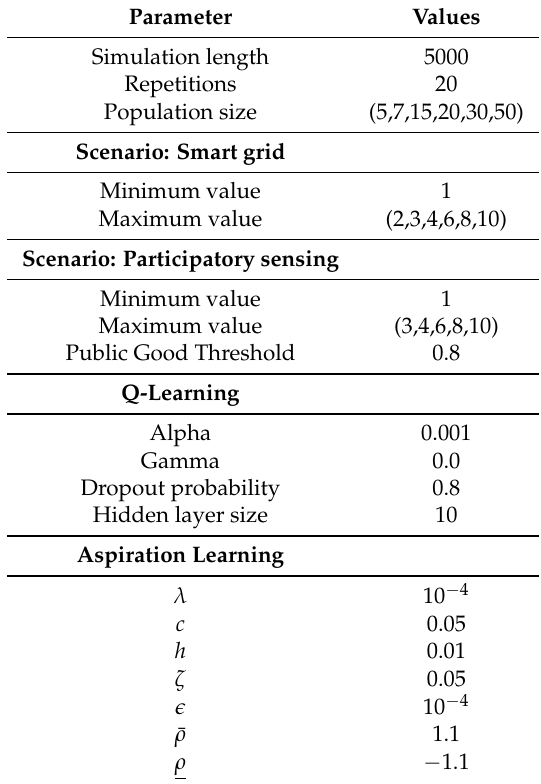
Table 4. List of parameters in the simulation environment. Tuples represent the values of parameters that have been tested during the parameter